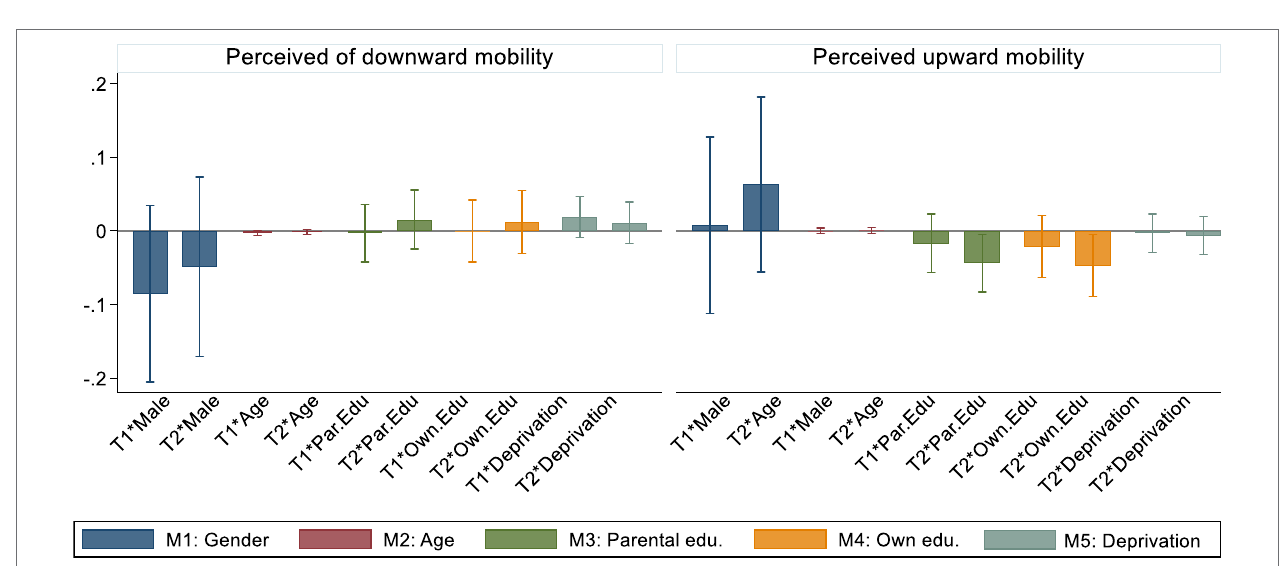
FIGURE 3 | Interaction terms between treatment assignment (T1 and T2) and respondents’ characteristics collected before the experimental component of the survey. Interaction terms with 95% confidence intervals. Linear probability models account for the main effects of respondents’ age, gender, parental education,